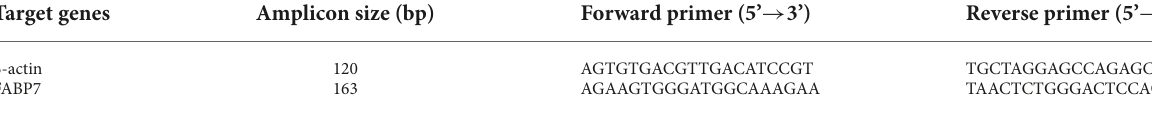
TABLE 2 Sequences of the primers used for quantitative real-time polymerase chain reaction. Target